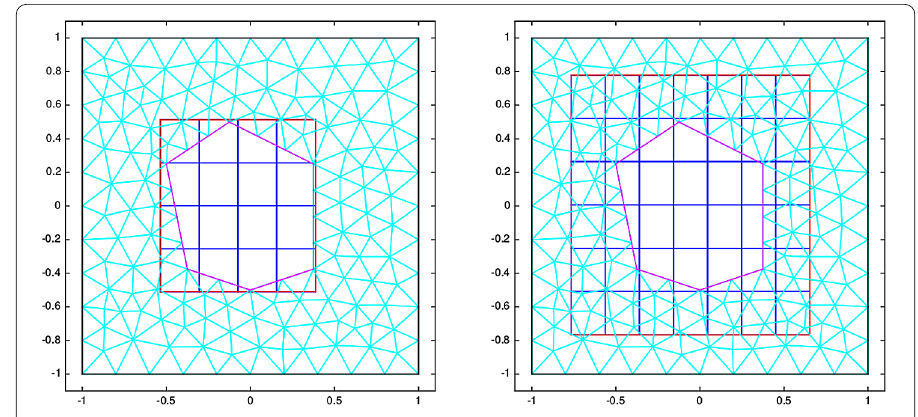
to have a minimaloverlap with (cid:9) ex h